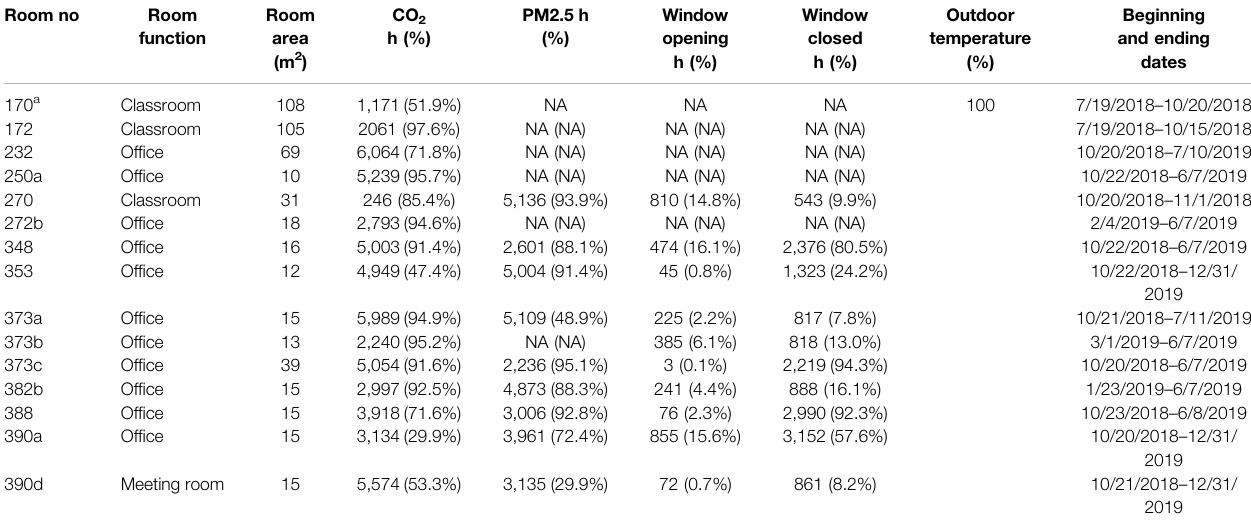
TABLE 1 | Available data amount for different